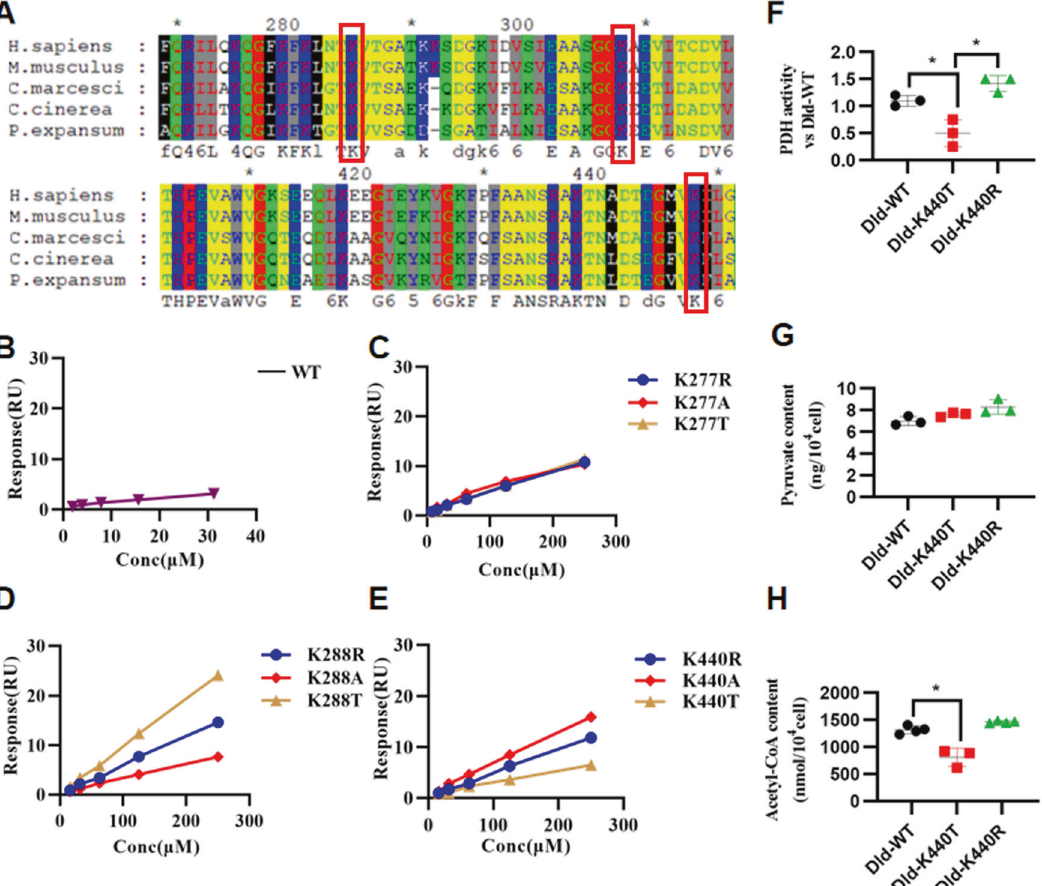
Fig. 3 The change of 2-hydroxyisobutylation level at K440 is a key point in the regulation of pyruvate metabolism by Rg3. A Multiple sequence alignment of DLD from different species. The conserved K277, K288, and K440 site were marked by the red boxes. B – E The binding ability of Rg3 with the DLD protein with or without site-directed mutagenesis were determined by surface plasmon resonance analysis. F The activity of pyruvate dehydrogenase in HEK293 cell with or without site-directed mutagenesis of DLD. G , H The contents of pyruvate and acetyl-CoA in HEK293 cell with or without site-directed mutagenesis of DLD. The data were analyzed using Kruskal Wallis test and were expressed as means ± SD, * p <